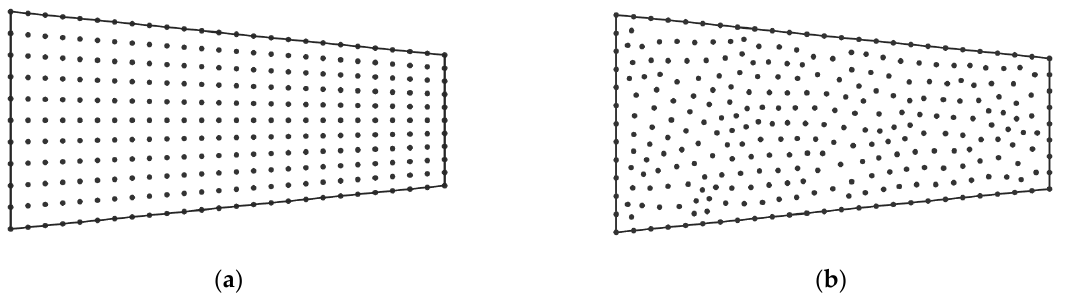
Figure 3. Nodal configuration for a variable-cross-section beam. ( a ) regular nodal distribution; ( b ) irregular nodal distribution.